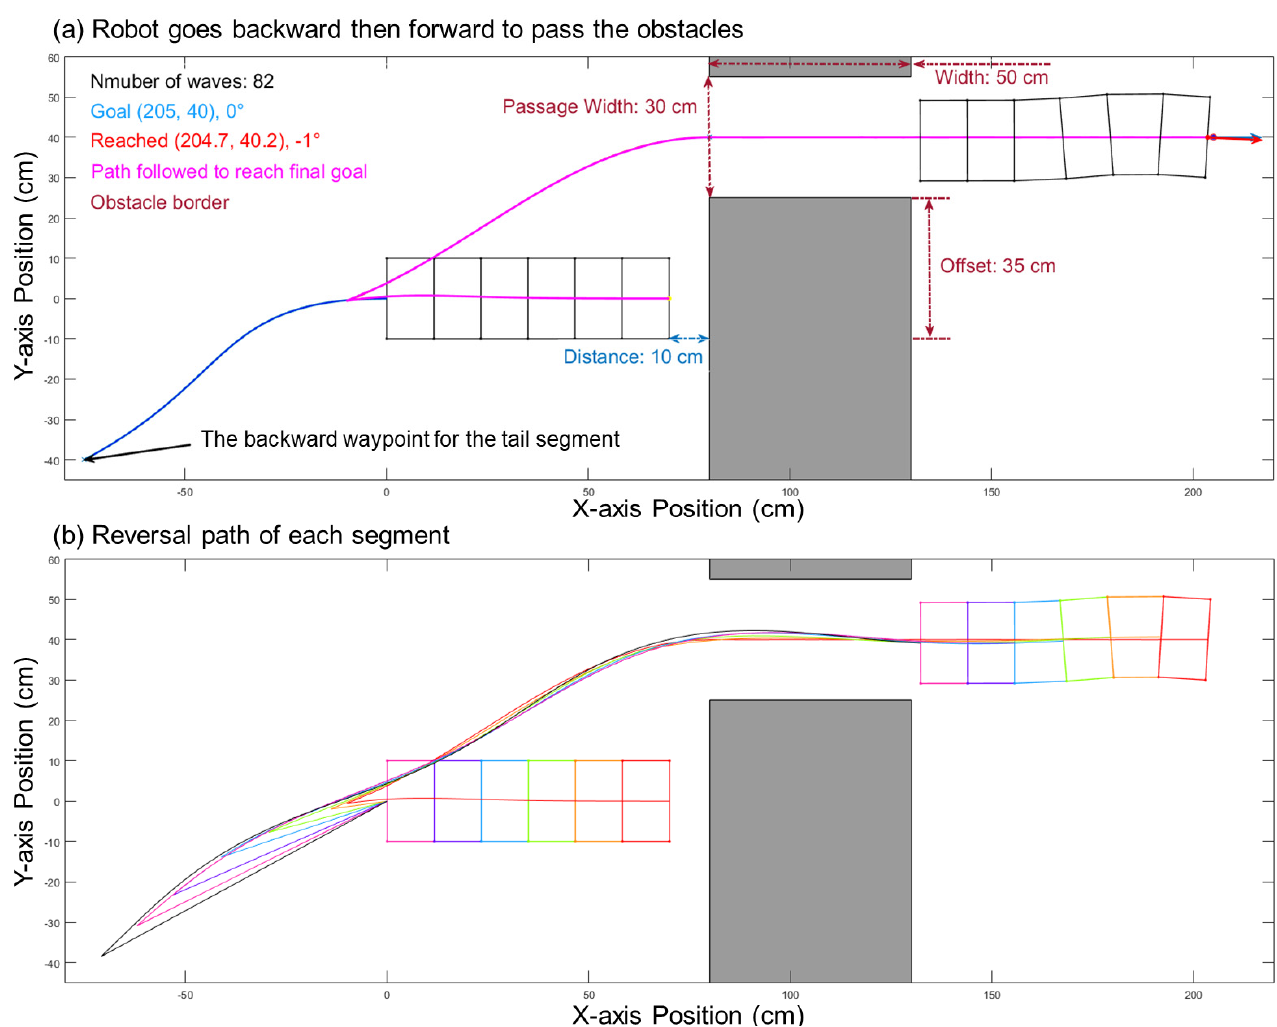
Figure 10. Backward motion is needed if the obstacle is too close. Here, the distance between the obstacles and the robot is 10 cm, and the offset is 35 cm, which is outside the range defined in previous figure (see dot). Therefore, it has to go backward first and then go forward. In ( a ), the robot follows the paths with a backward path, successfully passes through the obstacles, and reaches the goal. ( b ) shows the paths of each segment in different colors.